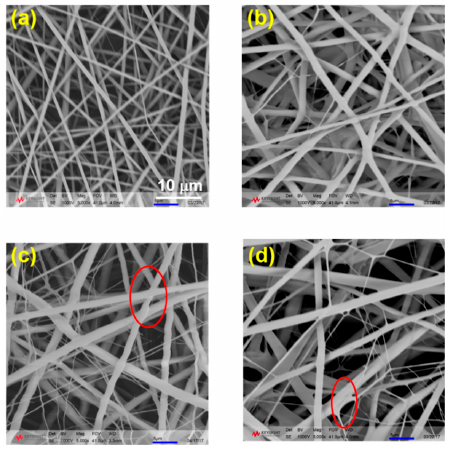
Figure 1. The morphology of poly (vinyl alcohol)/poly (lactic acid) (PVA/PLA) fibers with different weight ratios: ( a ) PLA; ( b ) L95V5; ( c ) L90V10; ( d ) L80V20. The magnification is 5000 ×